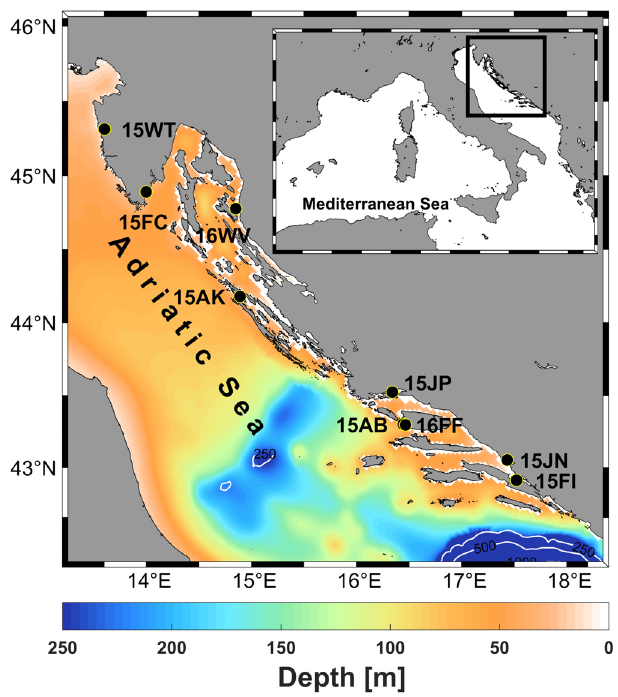
Fig. 1. Sampling locations of wild adult gilthead seabream (WT, Tar Bay; WV, Velebit Channel), wild juveniles (JP, Pantana River; JN, Neretva River), farm-associated adults (AK, Mrdina; AB, Maslinova) and farmed adults (15FC, Budava Bay; 15FI, Mali Ston Bay; 16FF Maslinova